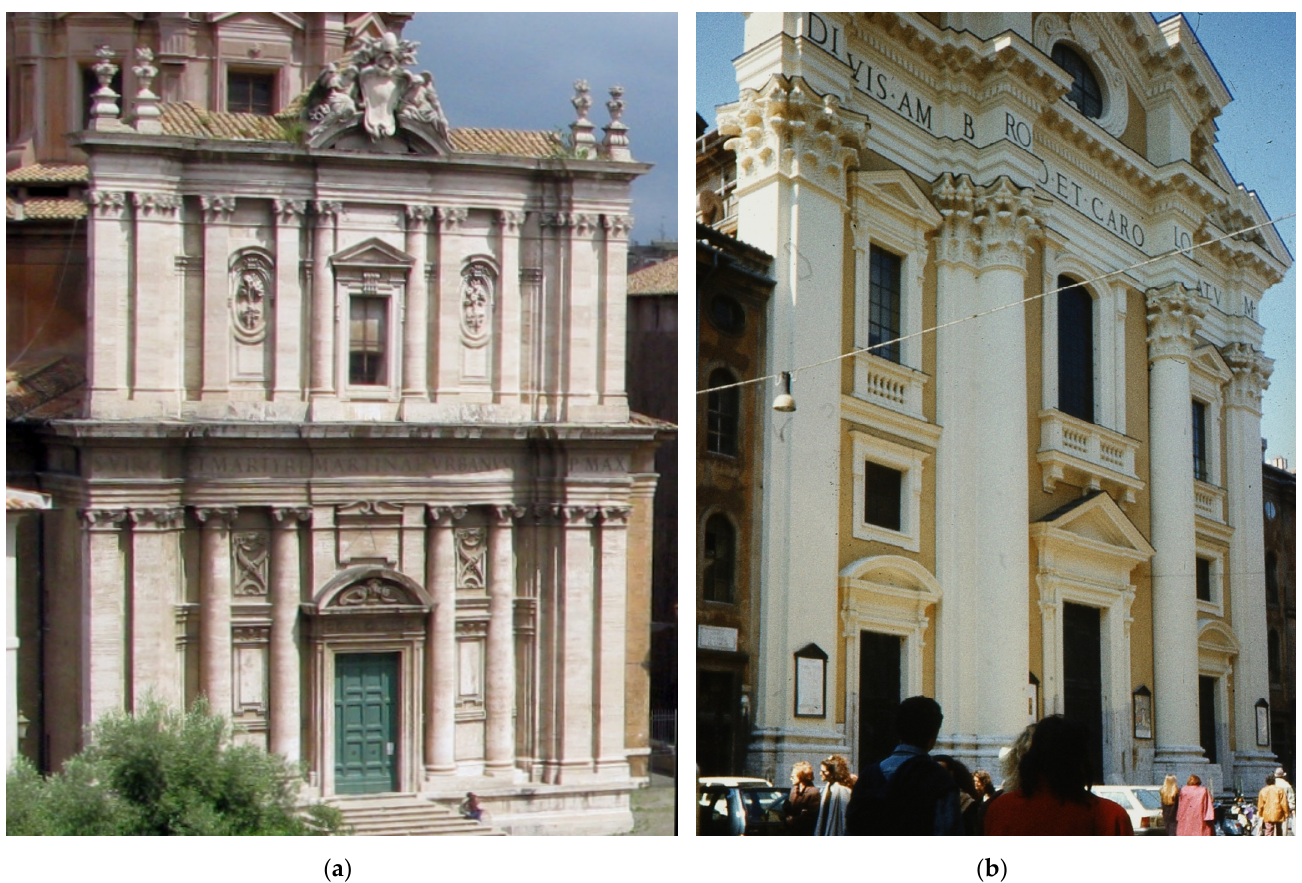
Figure 2. Monochrome architectural orders: ( a ) preserved small, balanced profiles within the details with subtle shadows, which ensured full visibility and clarity of the shapes. Cornices and architrave in the form of homogeneous stripes without ornamental detail. Fragment of the façade of the church of Santi Luca e Martina in Rome by Pietro da Cortona (1635–1664); ( b ) stone entablature with an inscription frieze and a combination of a different backgrounds on the façade of the church of the Lombard community in Rome, Santi Ambrogio e Carlo al Corso (1684), by Cardinal Luigi Alessandro Omodei. Photos by author and from private collection.